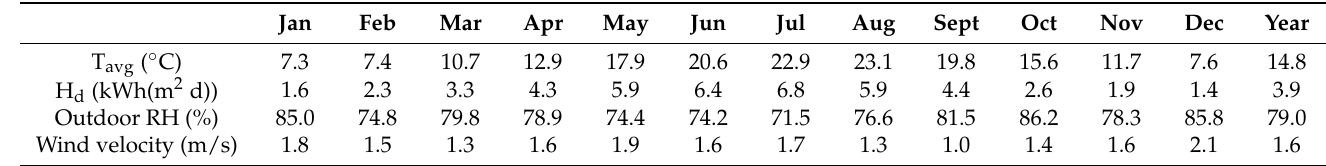
Table 3. Reference climatic data for central